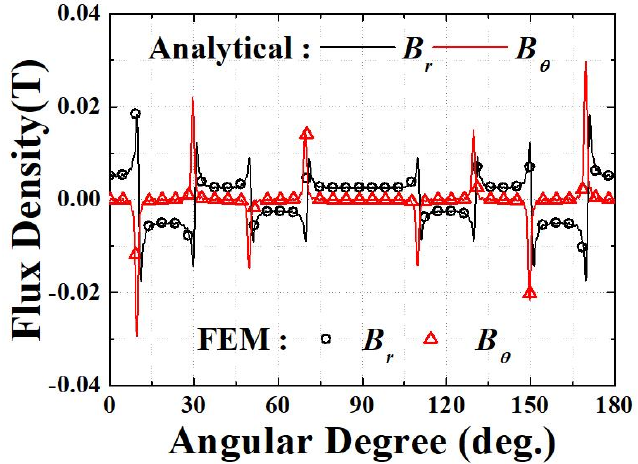
Figure 7. Comparison of armature reaction magnetic field characteristics.